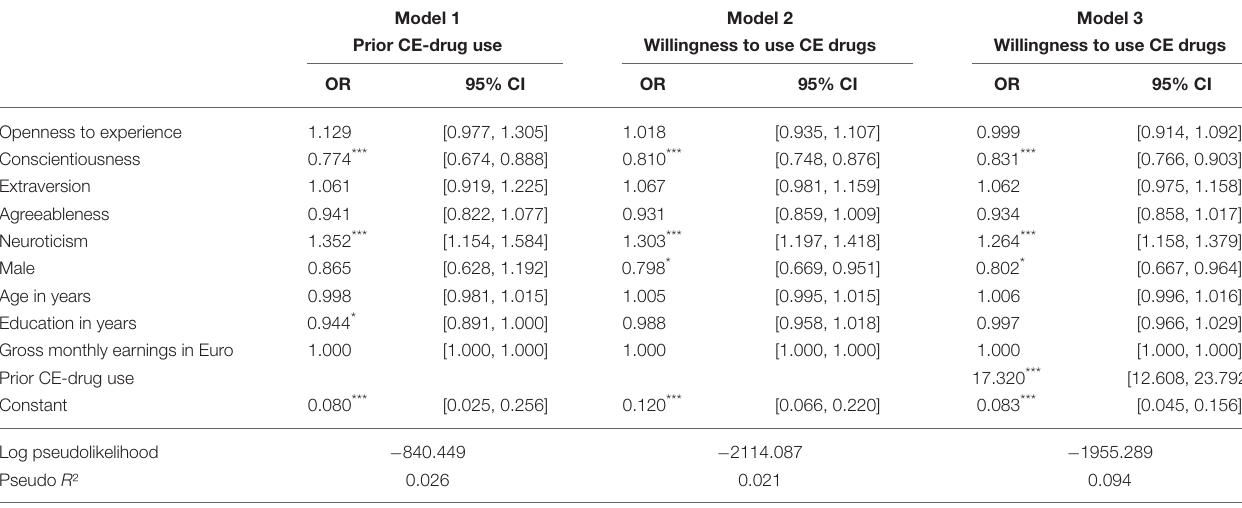
TABLE 2 | Logistic regression models to assess associations of the BFI-S and socio-demographic controls with prior CE-drug use (Model 1) and the willingness to use CE drugs (Model 2 and 3) with imputed data (Number of imputations = 20, Number of observations =